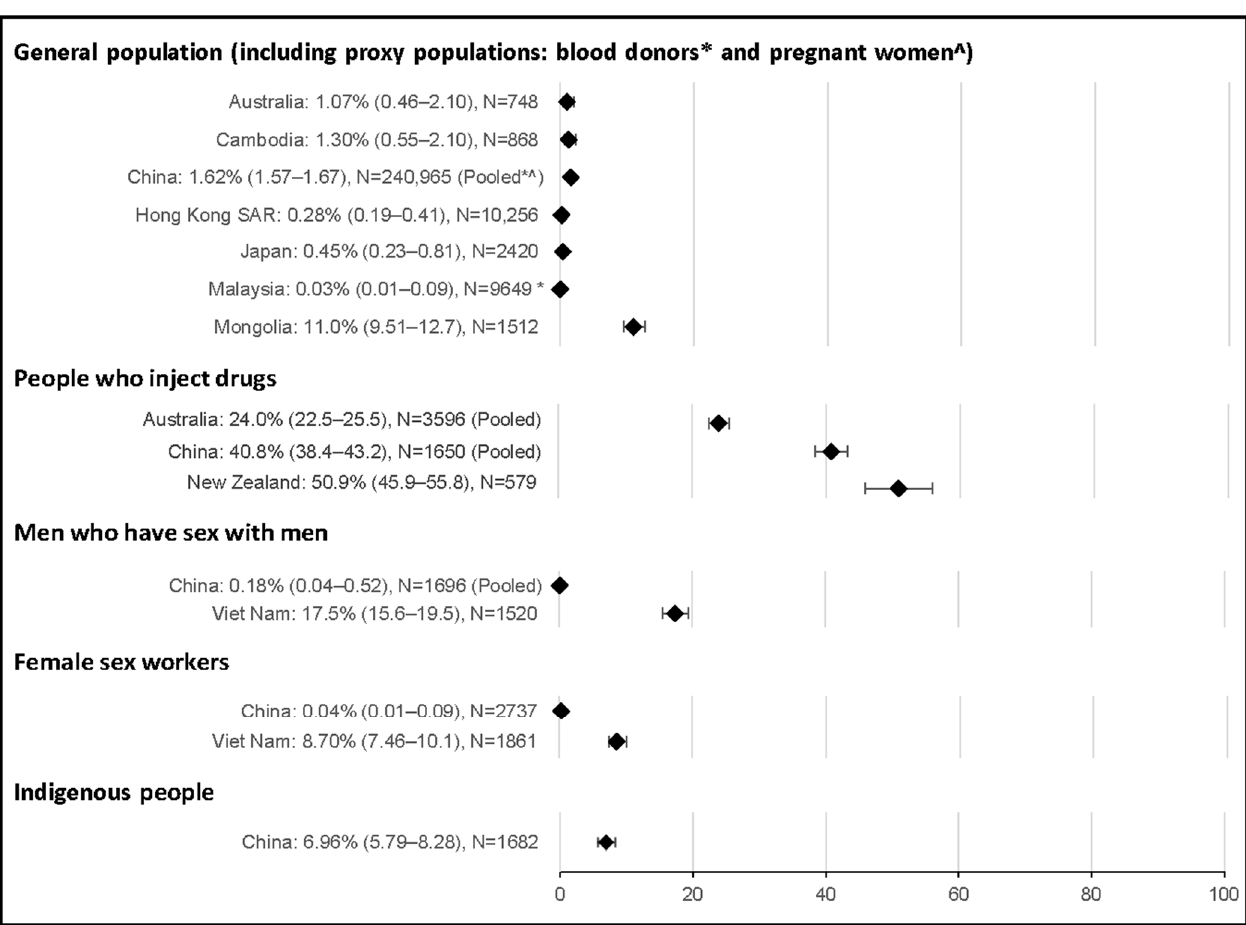
Figure 3. Forest plots HCV RNA prevalence by key population and country.